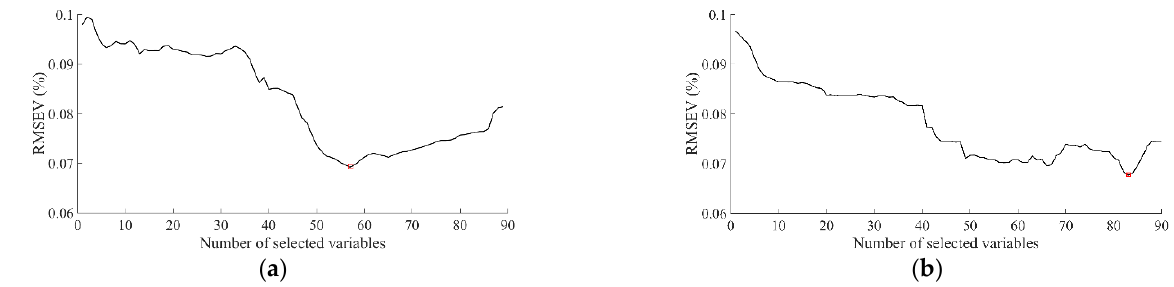
Figure 3. Changing processes of RMSEV with different wavelengths. ( a ) SPA; ( b ) MCUVE.